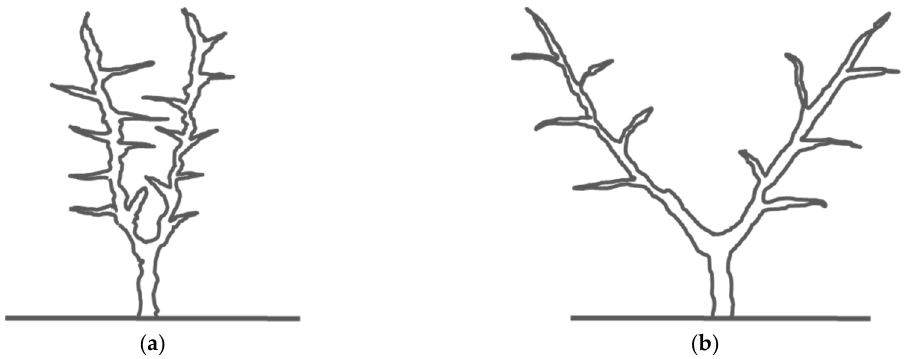
Figure 1 . Canopy systems of the nectarine/peach trees in the study site: ( a ) vertical leader; ( b ) Tatura Trellis.